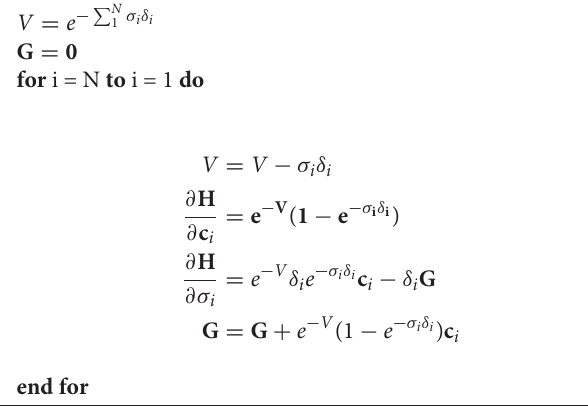
Algorithm 1 | Iterative algorithm for computation of partial derivatives of Equation (3).